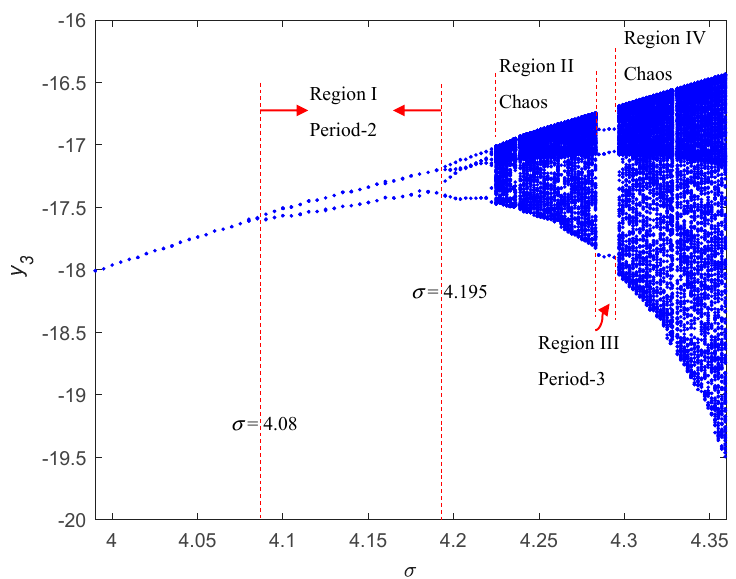
Figure 1. Bifurcation diagram of motor angular speed against σ .